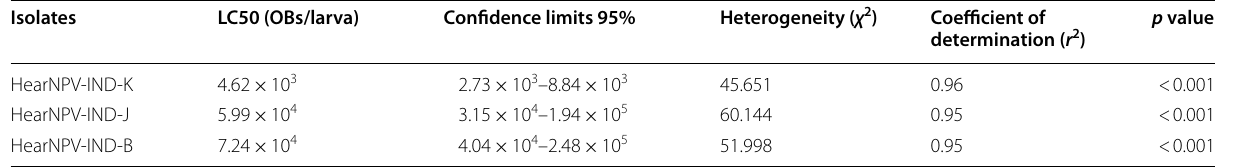
Table 1 Concentration response bioassays of three different HearNPV isolates against Helicoverpa armigera larvae over a period of